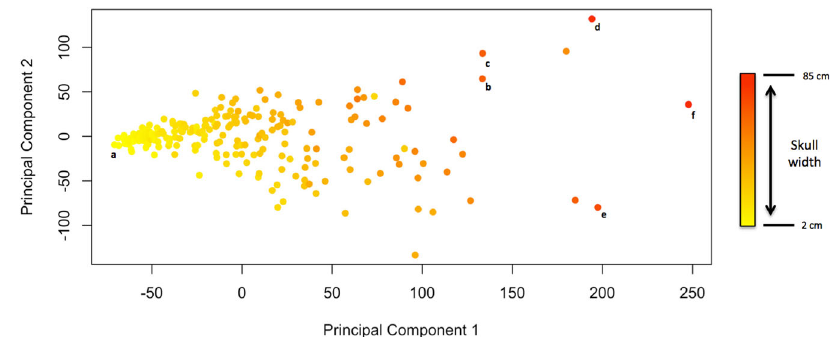
Fig. 6 Ordination morphospace of the fi rst two axes returned by the principal components analysis. Points are coloured according to relative skull width. This demonstrates the relationship between PC1 and body size, with larger taxa having higher PC1 scores. Note the colour gradient is not fully continuous along the x -axis, indicating taxa with disproportionately wide or narrow skulls. Notable taxa are indicated: ( a ) is the smallest taxon in the